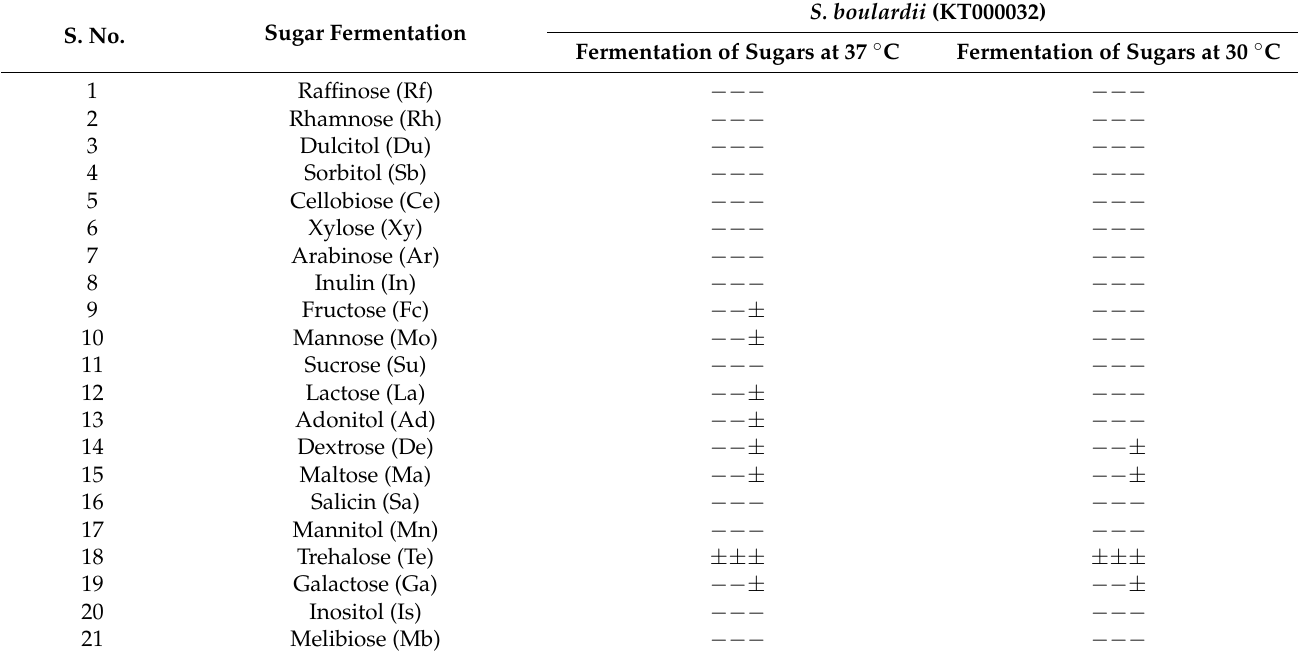
Table 8. The carbohydrate fermentation reactions of Saccharomyces boulardii strains after an incubation of 48 h at 37 ◦ C, of various bacteria. Differentiation discs were tested using Phenol Red Broth Base (M054). ( − ) negative reaction (pH > 6.8); ( ± ) weak reaction (pH 5.2 to 6.8); (+) positive reaction (pH < 5.2) after 24, 48, and 72 h, respectively. S. No.